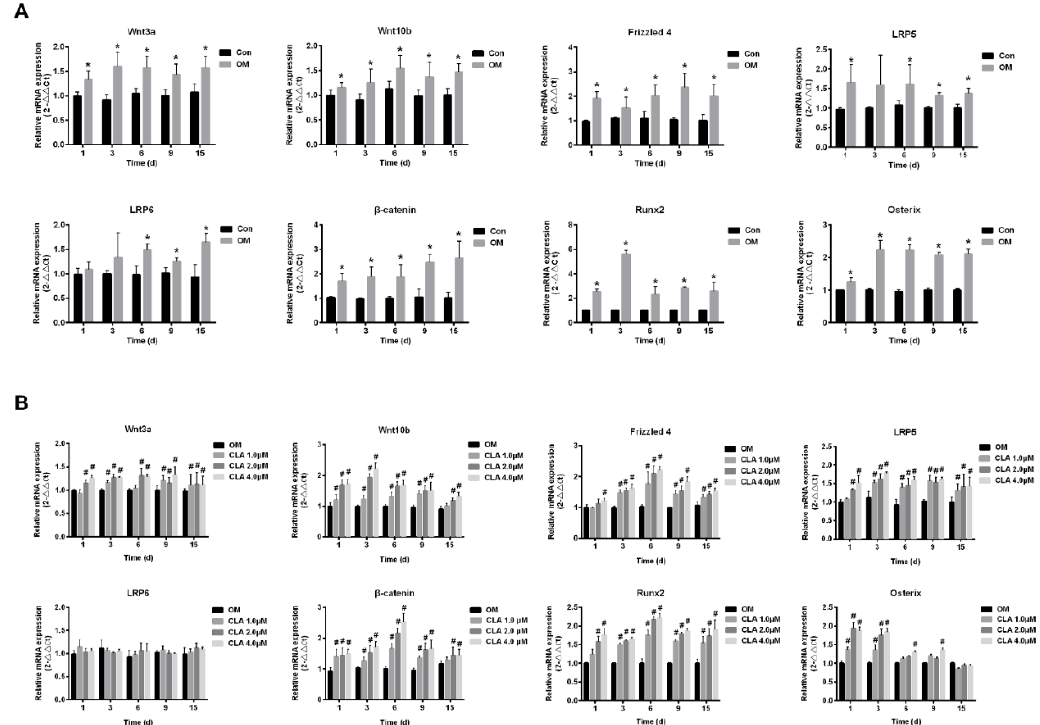
Figure 3. mRNA expression of Wnt/ β -catenin signaling pathway-related genes in differentiating hBMSCs. hBMSCs were maintained in growth medium (Con), or induced for osteogenic differentiation for 1, 3, 6, 9, or 15 d respectively, in the absence (OM) or presence of CLA (CLA). mRNA levels of respective genes were measured by RT-qPCR and normalized to GAPDH . ( A ) Comparison of mRNA expression levels of respective genes in Con and OM. ( B ) Comparison of mRNA levels of respective genes in OM and CLA. Data were expressed as mean ± SD ( n = 3). Compared to Con, data were significantly different at * p < 0.05; compared to OM, data were significantly different at # p < 0.05.